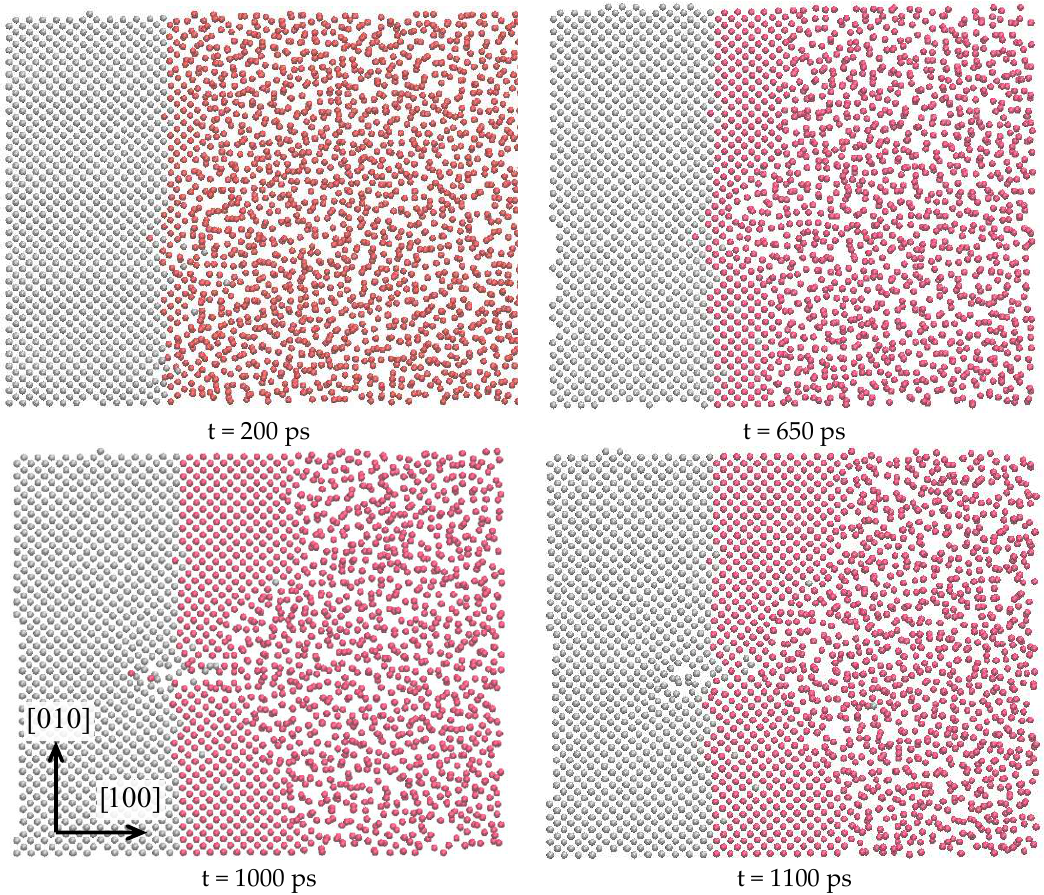
Figure 7. Sequential snapshots of the <100> growth with ε = −0.06. Only half of the simulation cell with two (001) atomic planes is displayed for visual convenience.